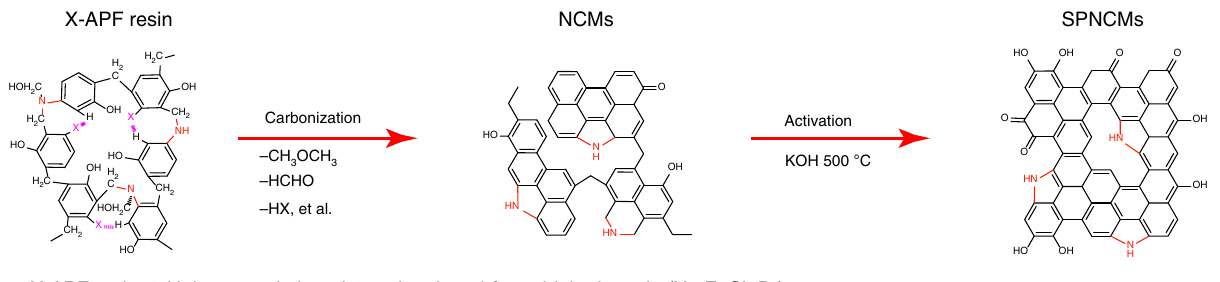
Fig. 1 Schematic of synthetic procedure of SPNCMs. The synthetic procedure of SPNCMs based on a strategy of low-temperature dehalogenation- induced and subsequent alkaline-activated pyrolysis of 3-halogenated phenol-3-aminophenol-formaldehyde (X-APF)